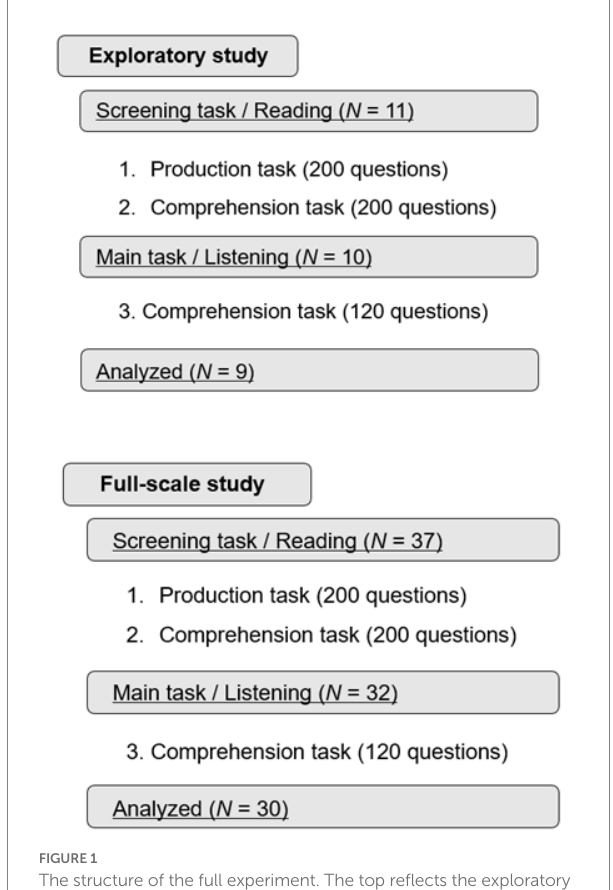
FIGURE 1 The structure of the full experiment. The top reflects the exploratory study and the bottom reflects the full-scale study. The screening phase included a translation task to measure the productive and comprehensive knowledge of various phrases. All the stimuli in the screening task were presented visually. The main task included a listening comprehension task. All the stimuli in the main task were presented in an auditory